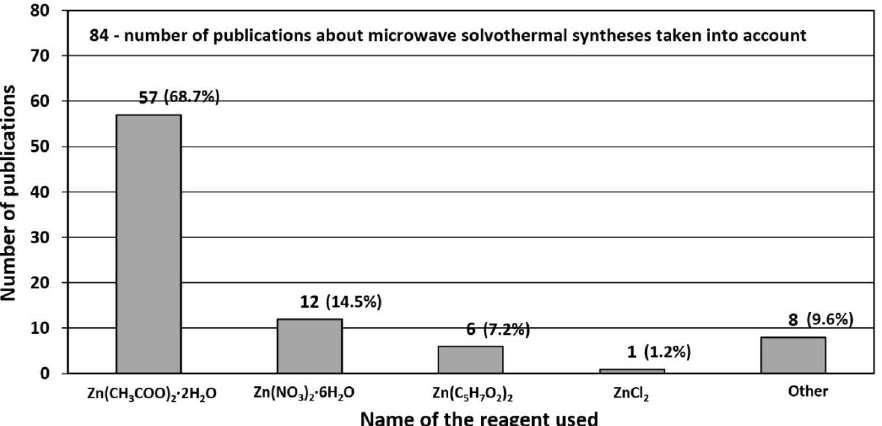
+ salts)inthemicrowavesolvothermalsynthesis. Source:[402, Figure 36. Statistics of use of reactants (Zn 2+ salts) in the microwave solvothermal synthesis. Source: Figure36. Statisticsofuseofreactants(Zn 2